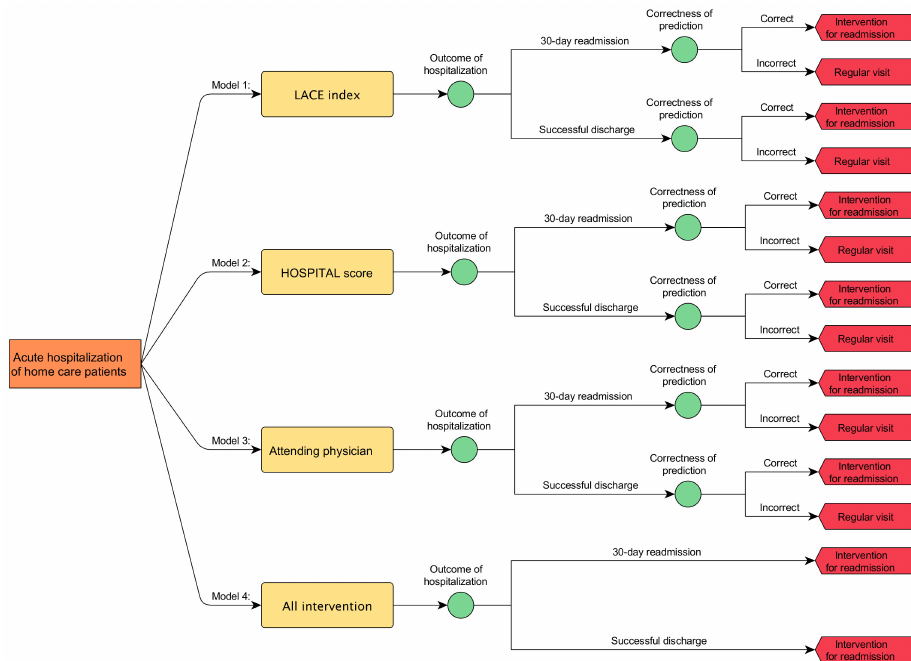
Figure 2. Microsimulation model to compare cost-e ff ectiveness of four readmission prediction models when applied to acute hospitalizations of a disabled cohort of a medical center a ffi liated home care unit in Taiwan, 2017. ( n =